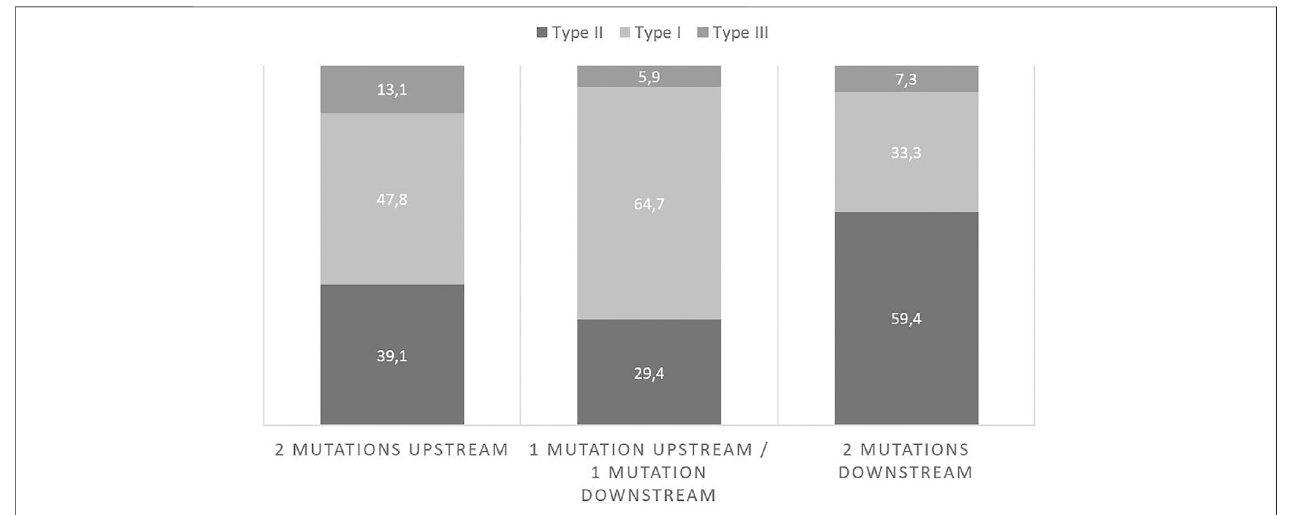
FIGURE 2 | Proportions of subtypes in each mutation group.